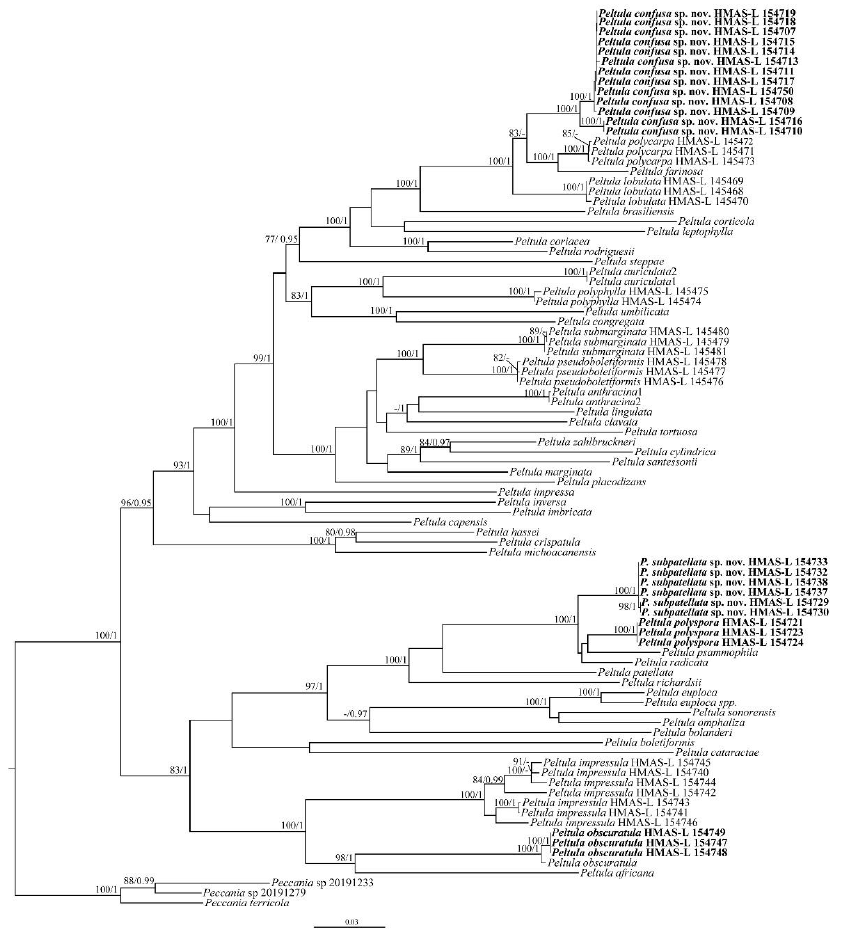
Figure 1. The RAxML tree of Peltula species based on the concatenated ITS + nrSSU + nrLSU + RPB2 data set. The numbers in each node represent bootstrap support (BS) and posterior probability (PP) values. BS values ≥ 75 and PP values ≥ 0.95 are plotted on the branches of the tree. The clades corresponding to the new species and the new records are in bold. The scale bar is 0.03 substitutions per site.